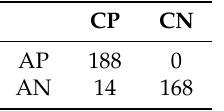
Figure 15. Estimation error in the dynamic hazardous object detection.